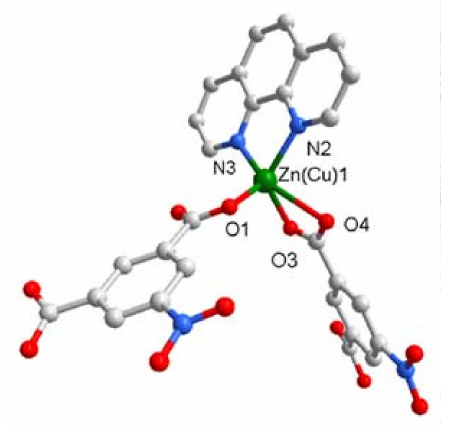
Figure 1. Coordination geometries of Complex.